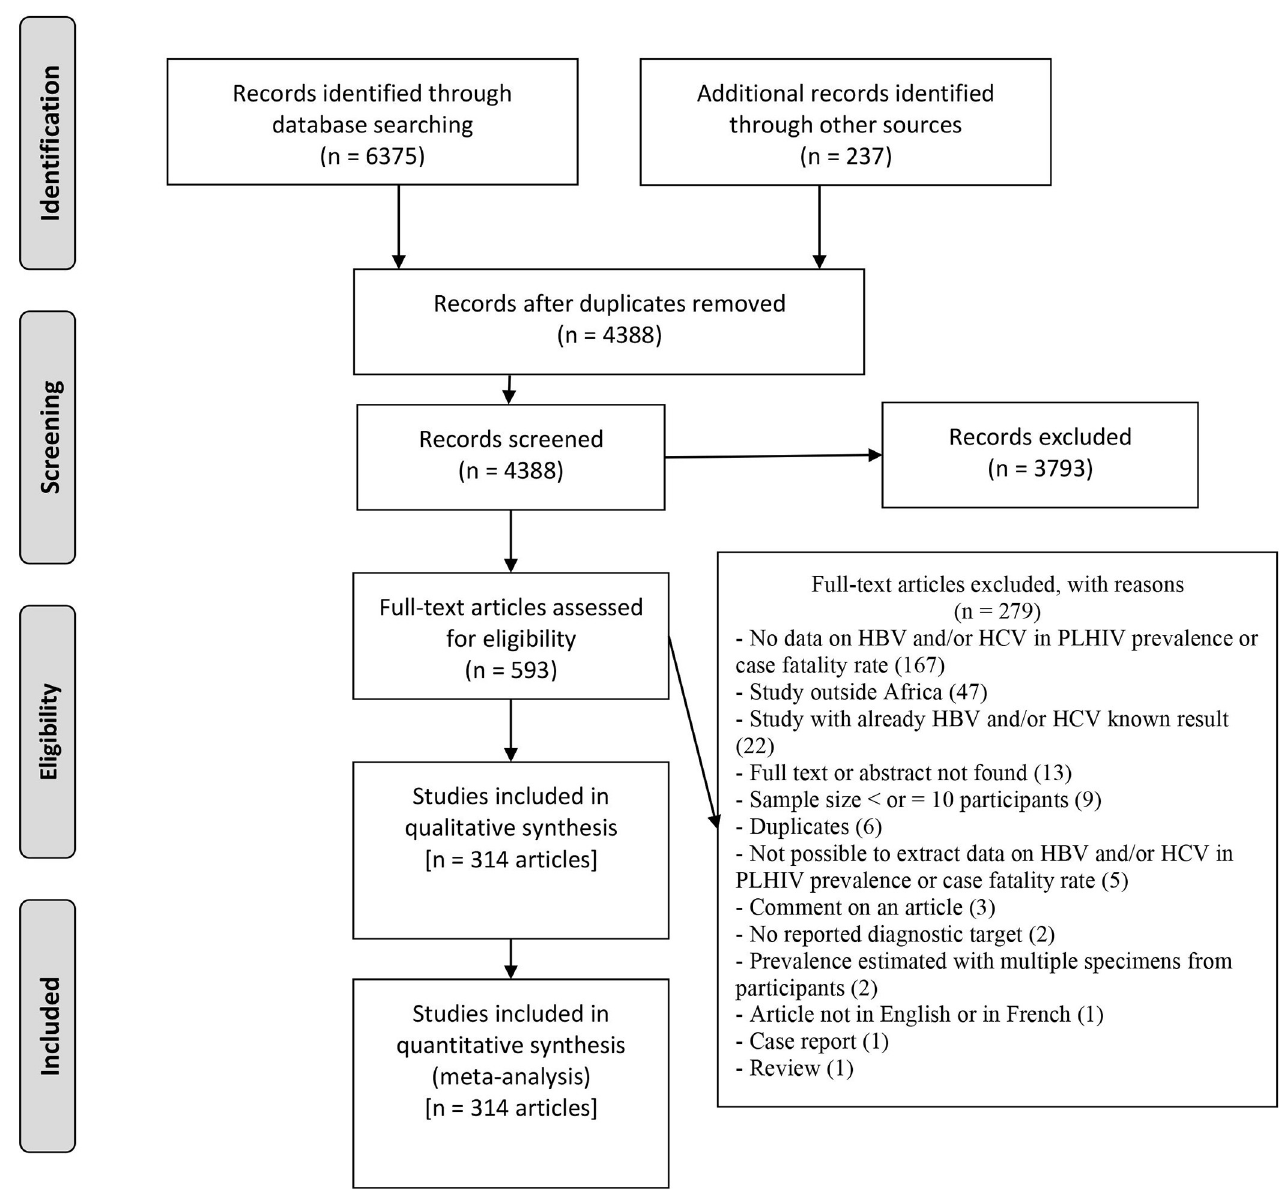
Fig 1. Flowchart for retrieving and processing article selection. https://doi.org/10.1371/journal.pone.0269250.g001 12.1) in West Africa. A statistically significant heterogeneity was observed in the overall esti- mate of the HBV CFR estimate (I 2 = 83.4% [62.4%; 92.7%], p < 0.0001). The review of Egger’s regression test results (Table 1) and the funnel plot (S1 Fig) suggested no publication bias (P = 0.283). We obtained no data on the CFR of HCV in PLHIV. Pooled prevalence estimate of hepatitis B virus infection in PLHIV in Africa A total sample size of 324305 participants from 32 countries was considered for HBV preva- lence estimates in PLHIV in Africa (Figs 2 and 4, S2 Fig). The overall prevalence of HBV infection in PLHIV was 10.5% [95% CI = 9.6–11.3], with statistically significant heterogeneity